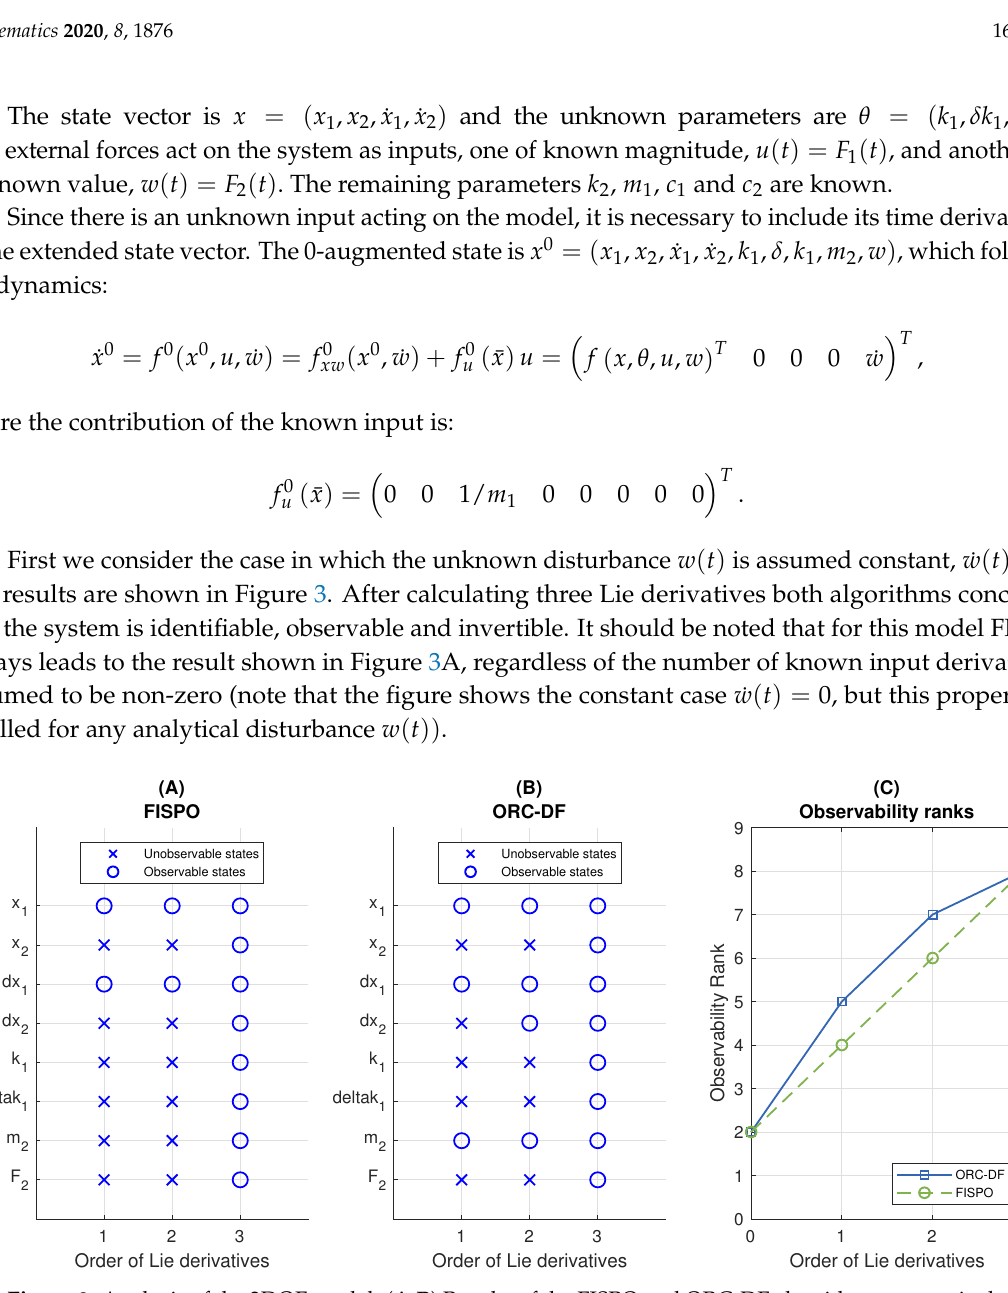
Figure 3. Analysis of the 2DOF model. ( A , B ) Results of the FISPO and ORC-DF algorithms, respectively, with ˙ w = 0. The panels show the states classified as observable or unobservable as a function of the number of Lie derivatives calculated by each algorithm. ( C ) Observability rank obtained by each algorithm as a function of the number of Lie derivatives. The full rank is equal to the number of states, i.e.,